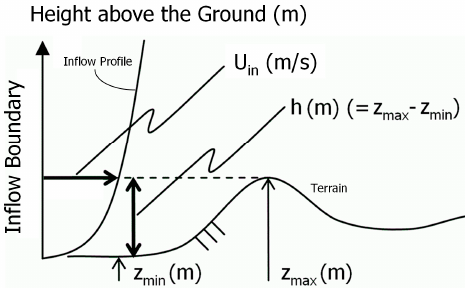
Figure 19. Two characteristic scales (U in and h).